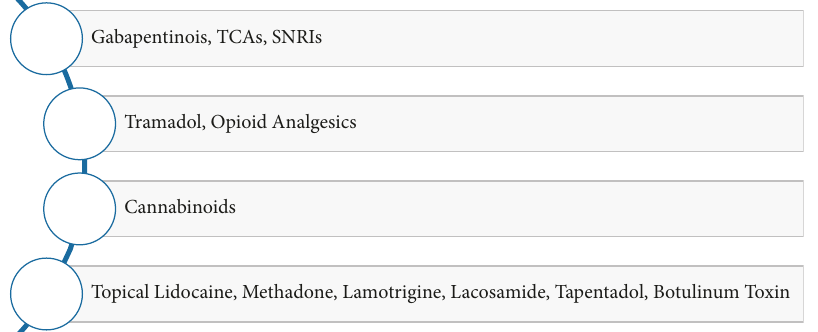
Figure 2: Consensus statement for the management of chronic neuropathic pain by the Canadian Pain